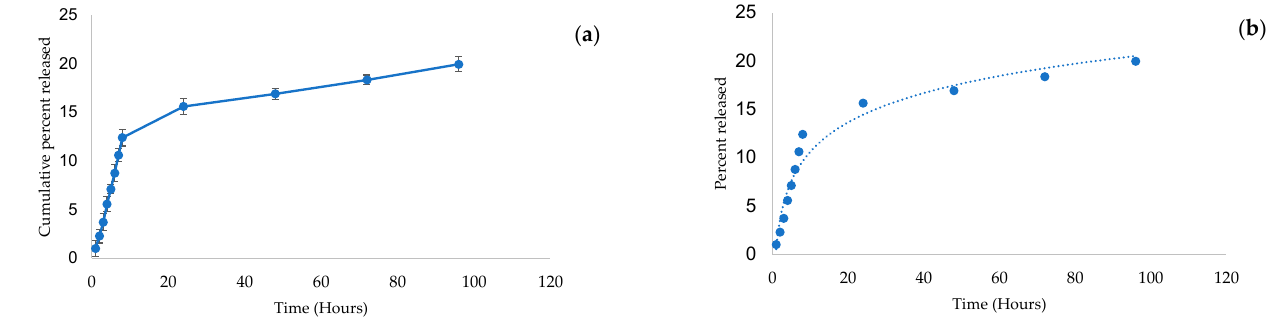
Figure 7. Release profile from transferosomes: ( a ) In vitro release of CysA from transferosomes; ( b ) The predicted release profile based on the Korsmeyer–Peppas model.